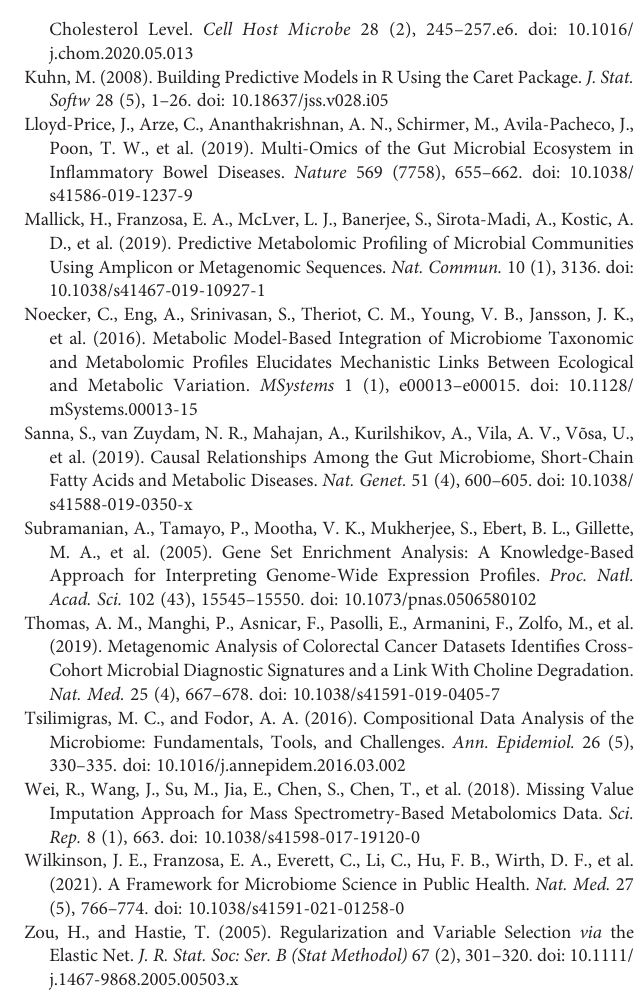
predicted metabolites in ZOE 2.0 by ENVIM. Rank is based on the weight matrix in ENVIM. A larger number of ranks suggests more important gene